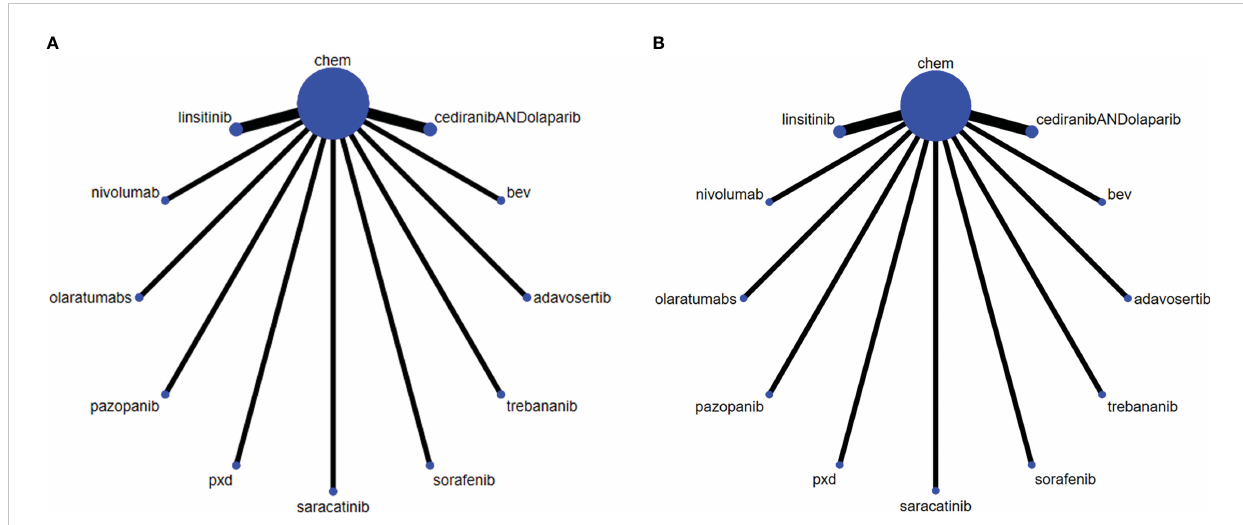
FIGURE 2 The network of each intervention for (A) PFS and (B) OS. The width of the lines represents the number of studies under direct comparison. The thicker the line, the greater the number of studies.